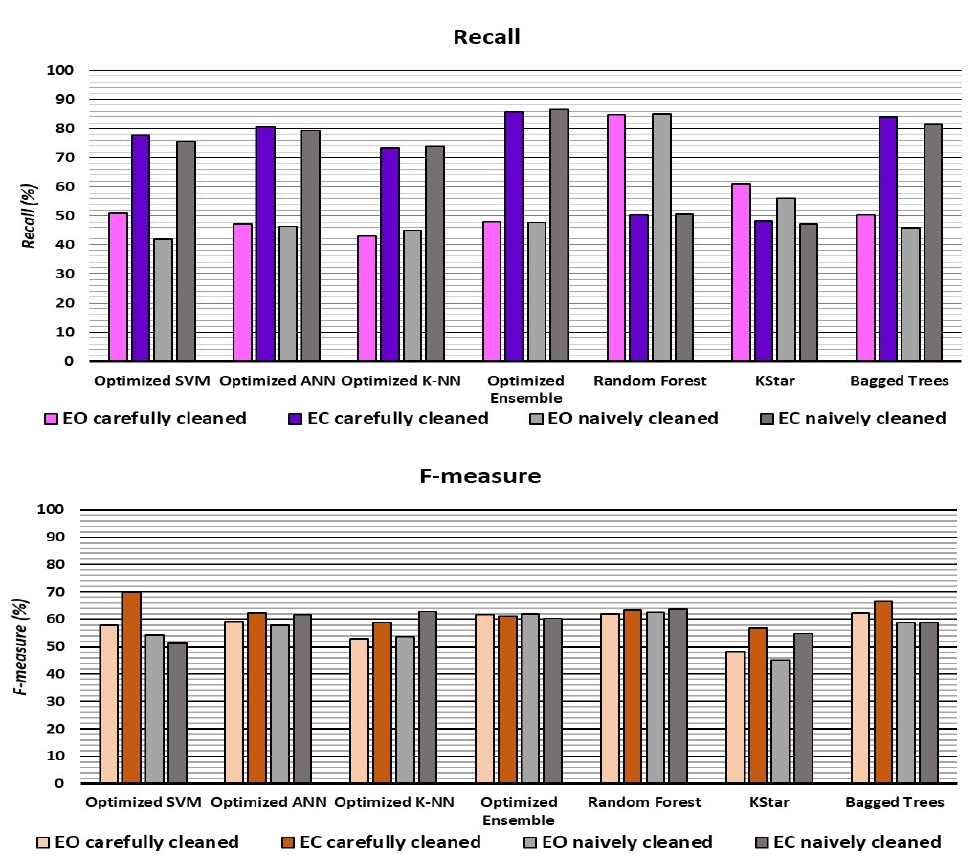
Figure A1. The precision, recall and F-measure for the comprehensively preprocessed and simply preprocessed data, with the classifiers trained on the data derived from 40 subjects and tested on the data derived from the withheld data of ten subjects.